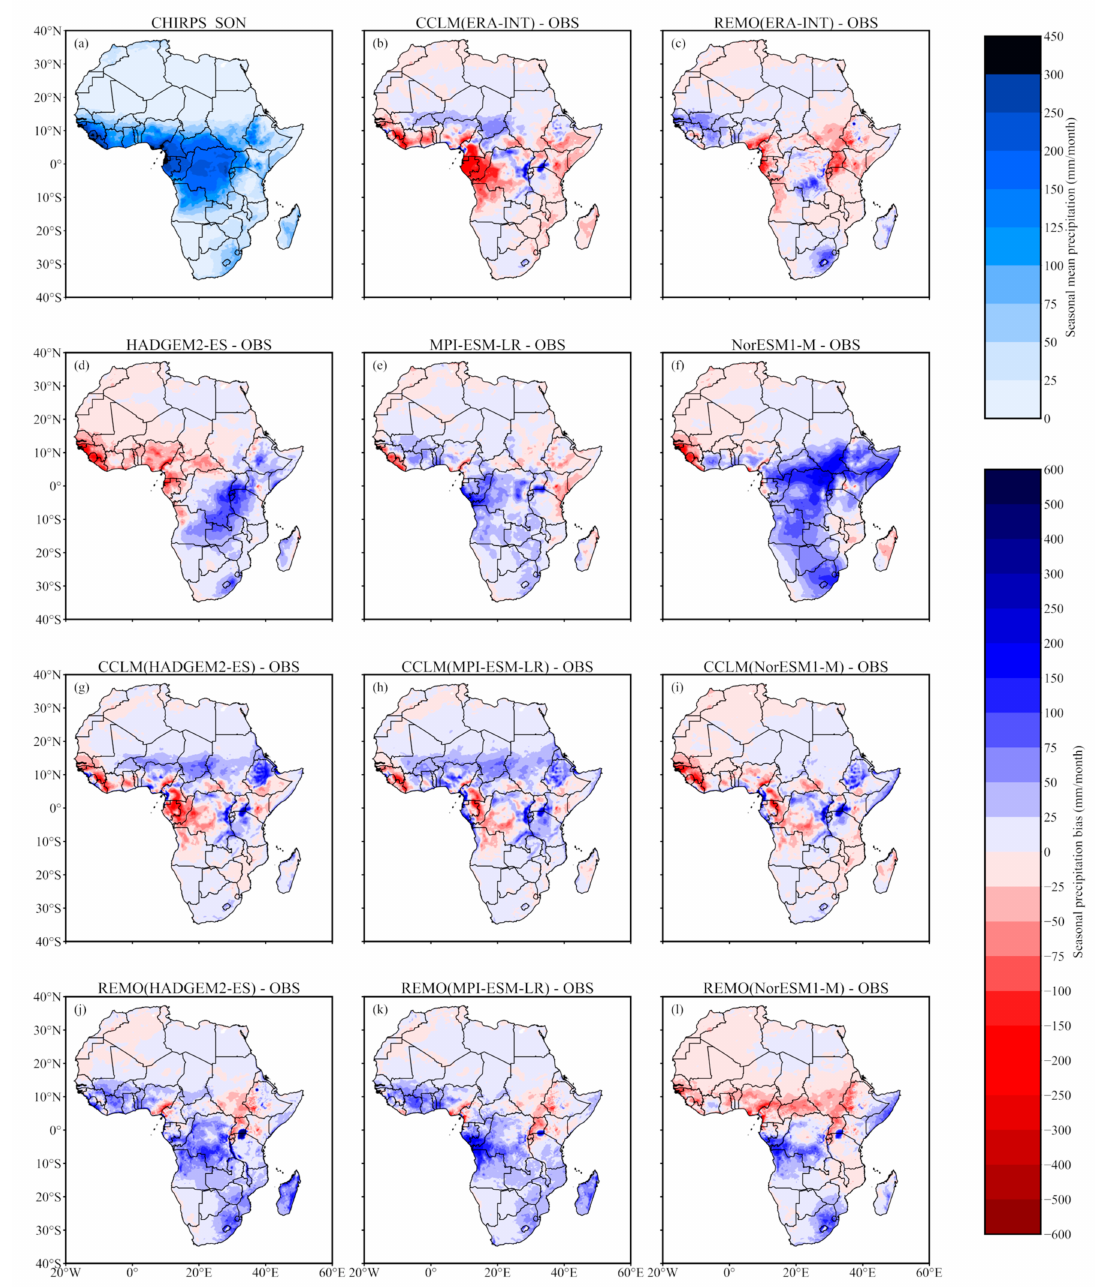
Figure 5. Bias of monthly precipitation in SON, compared to CHIRPS, for GCMs, CCLM, and REMO: ( a ) CHIRPS ( b ) CCLM (ERA–INT)-CHIRPS, ( c )REMO (ERA–INT)-CHIRPS, ( d ) HadGEM2–ES–CHIRPS, ( e ) MPI–ESM–LR–CHIRPS, ( f ) NorESM1– M-CHIRPS, ( g ) CCLM (HadGEM2–ES)-CHIRPS, ( h ) CCLM (MPI–ESM–LR)–CHIRPS, ( i ) CCLM (NorESM1–M)–CHIRPS, ( j ) REMO (HadGEM2–ES)–CHIRPS, ( k ) REMO (MPI–ESM–LR)–CHIRPS, ( l ) REMO